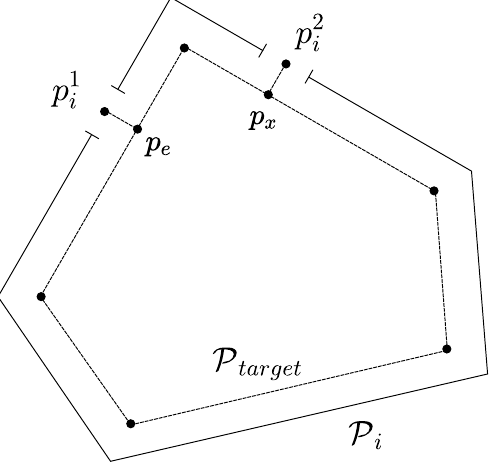
Figure 3. Illustration of the polygon and points construction for a target